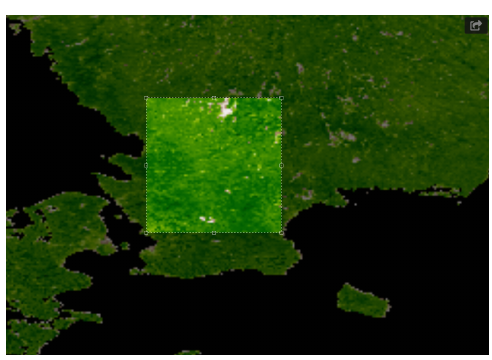
of 28 × 28 pixels, with a resolution (per pixel) of 5